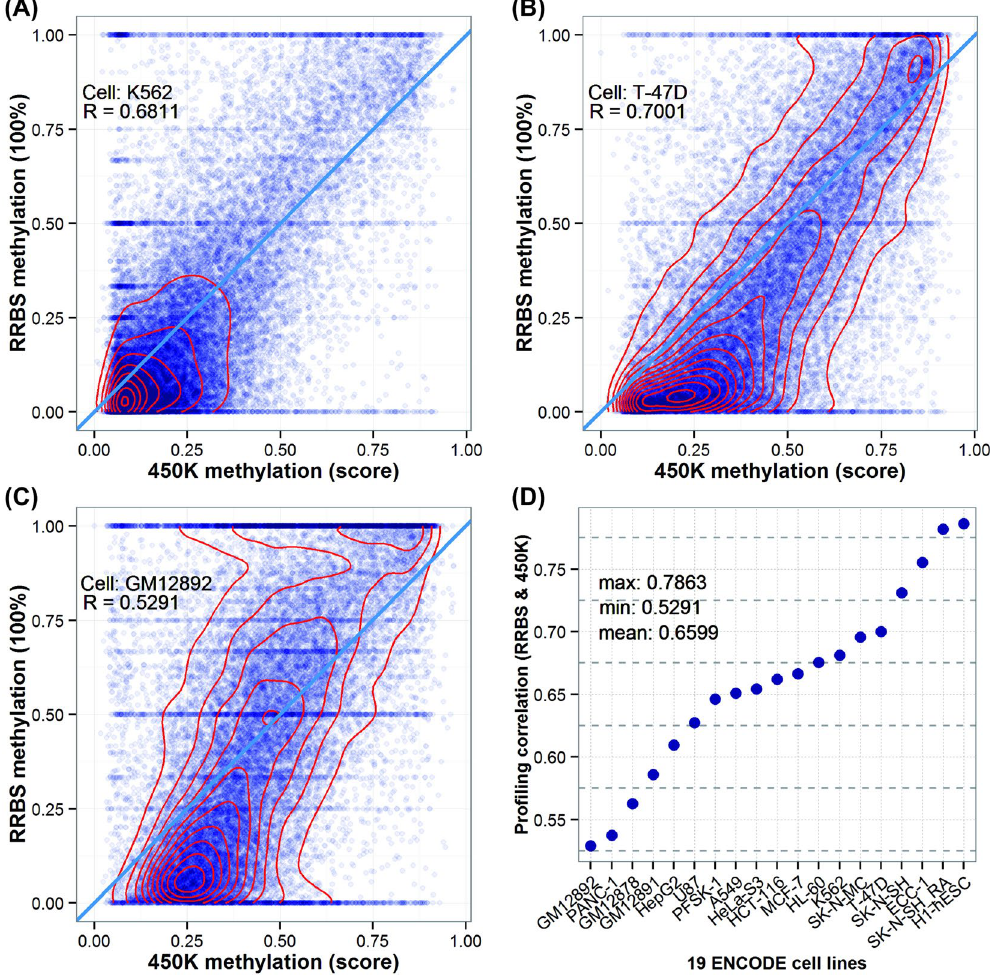
Figure 1. Genome-wide DNA methylation profiling comparison between two major platforms, Illumina Infinium Methylation Beadchip 450 K vs . RRBS. ( A – C ) Provide the illustrative examples for the three DNA methylation distribution patterns (unimodal, bimodal and trimodal) and corresponding Pearson correlation coefficient between two profiling platforms (top left corner); ( D ) presents the correlation statistics between two DNA methylation profiling platforms across the 19 ENCODE cell